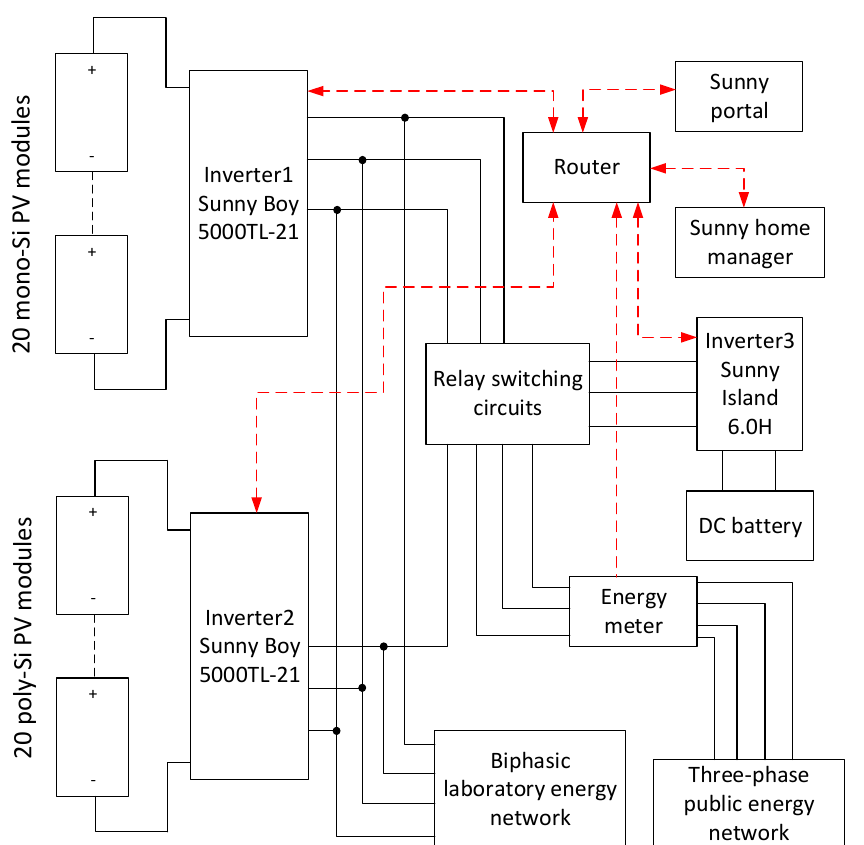
Figure 1. Block diagram of the investigated photovoltaic